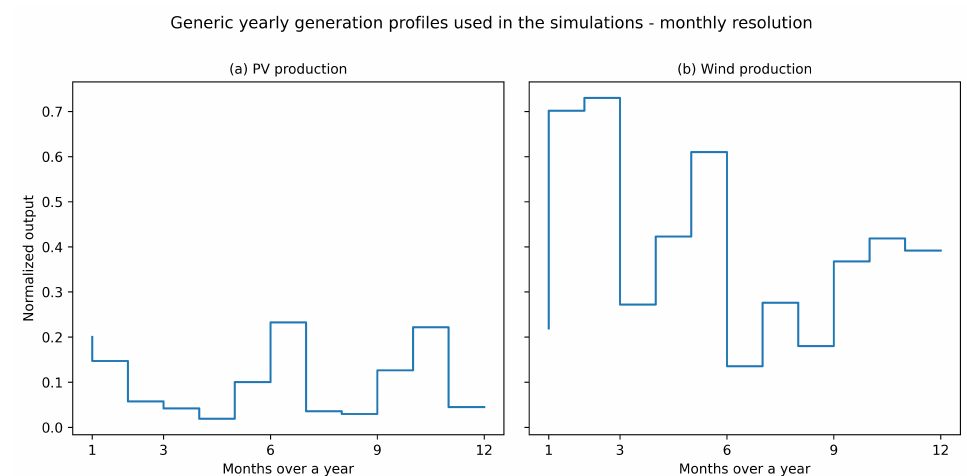
Figure 13. Production profile of DGs with monthly resolution: ( a ) PV DG; ( b ) wind DG.